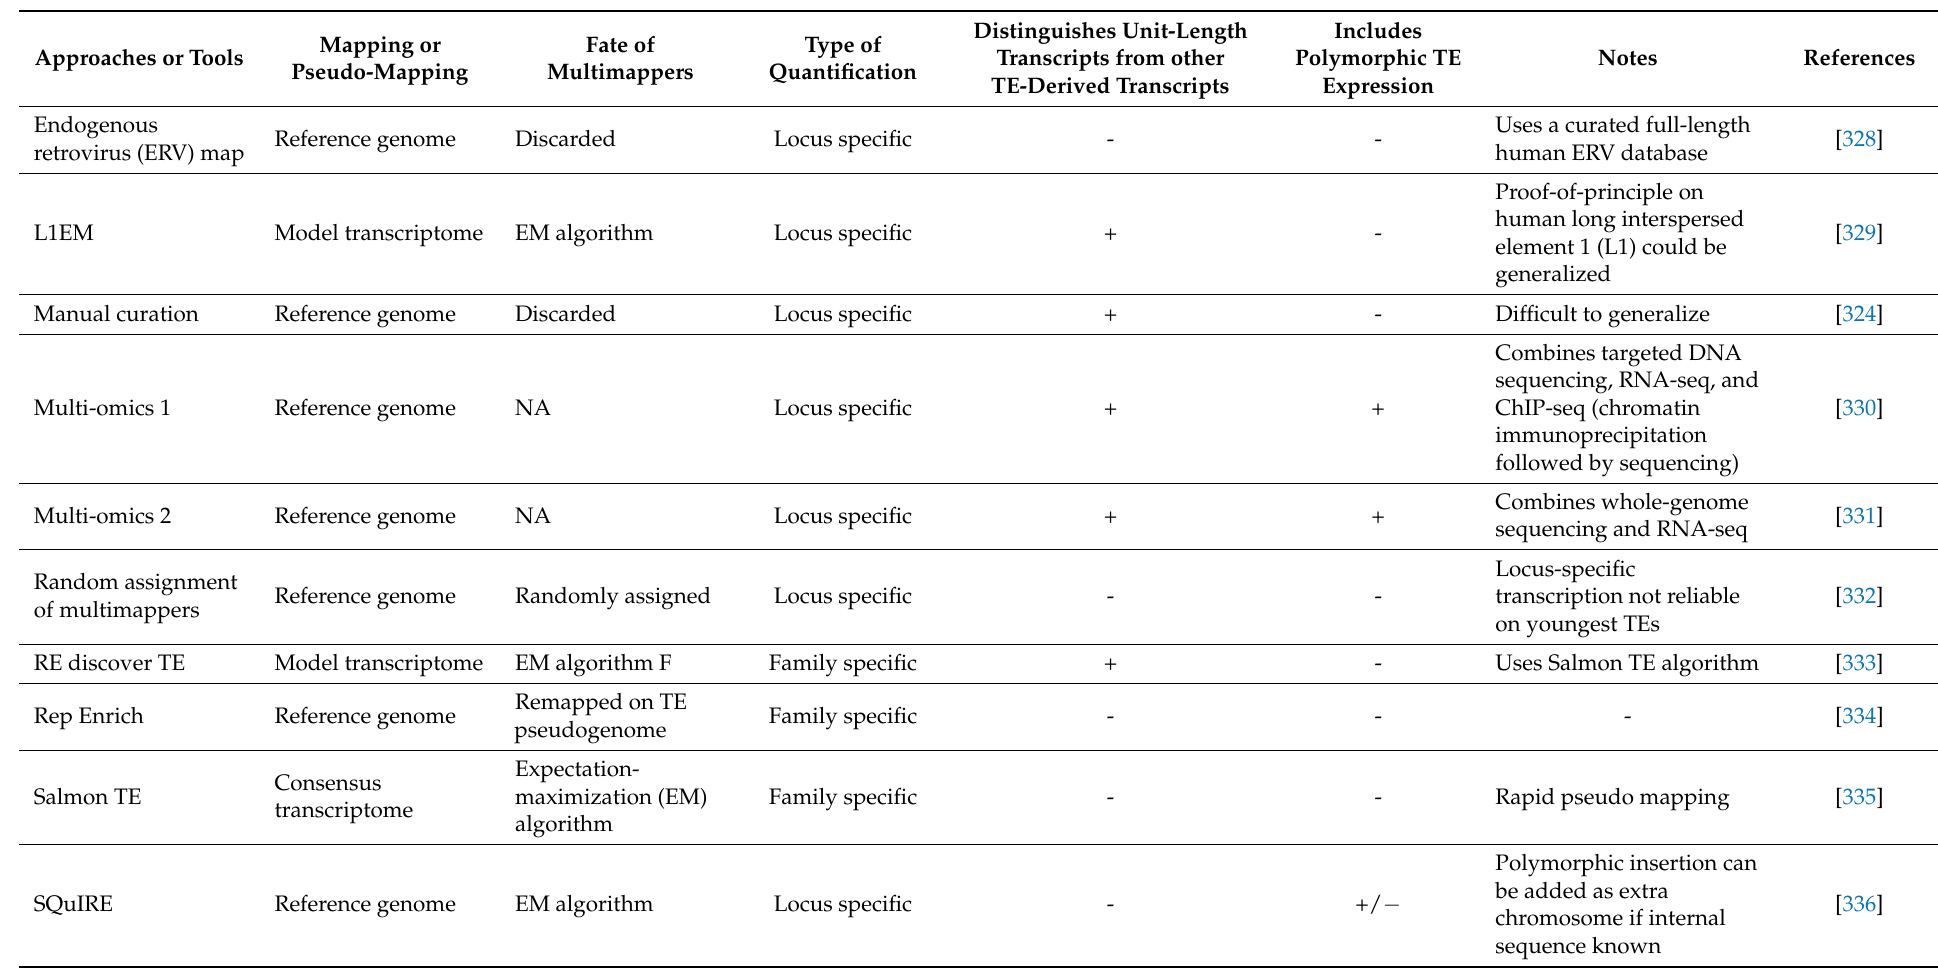
Table 5. Analysis of transposable element (TE) unit expression from RNA-seq results using statistical methods and approaches. The table was adapted and recreated from Lanciano et al. [317], with copyright permission from the Licensor Springer Nature (Nature Reviews Genetics: Nature publisher) and Copyright Clearance Center (https://www.copyright.com) (Supplementary File